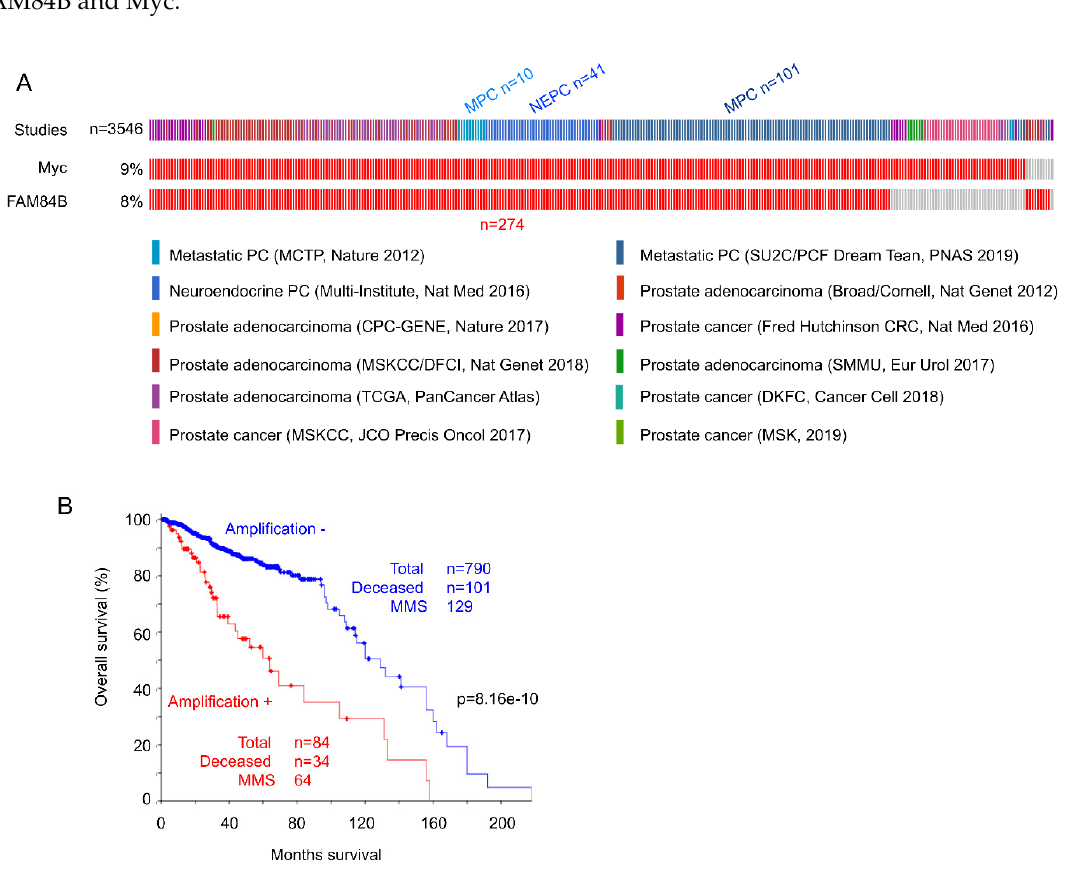
Figure 4. Co-amplification of FAM84B and Myc associates with poor prognosis in prostate cancer. ( A ) The 12 published studies within cBioPortal with a total number of patients n = 3546 were analyzed for amplification of the Myc and FAM84B genes. Individual tumors with amplification of either genes are shown, and only tumors with the indicated gene amplification are included. MPC: metastatic prostate cancer; NEPC: neuroendocrine prostate cancer. ( B ) PCs with co-amplification of FAM84B and Myc are associated with reductions in overall survival. Kaplan–Meier curve and log-rank test were performed using the program provided by cBioPortal. MMS: median months survival.